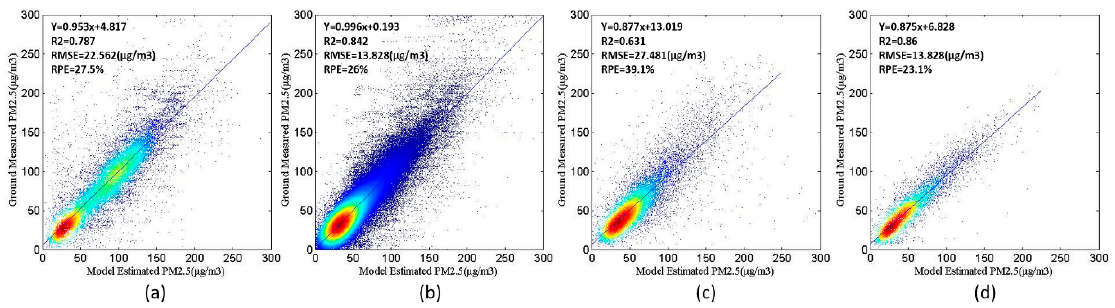
Figure 5. The accuracy evaluation of the second-stage GAM model on groups (i) + (ii). ( a , b ): 2013; ( c , d ): 2014; ( e , f ): 2015; and ( g , h ): 2016. The red lines are regression lines.